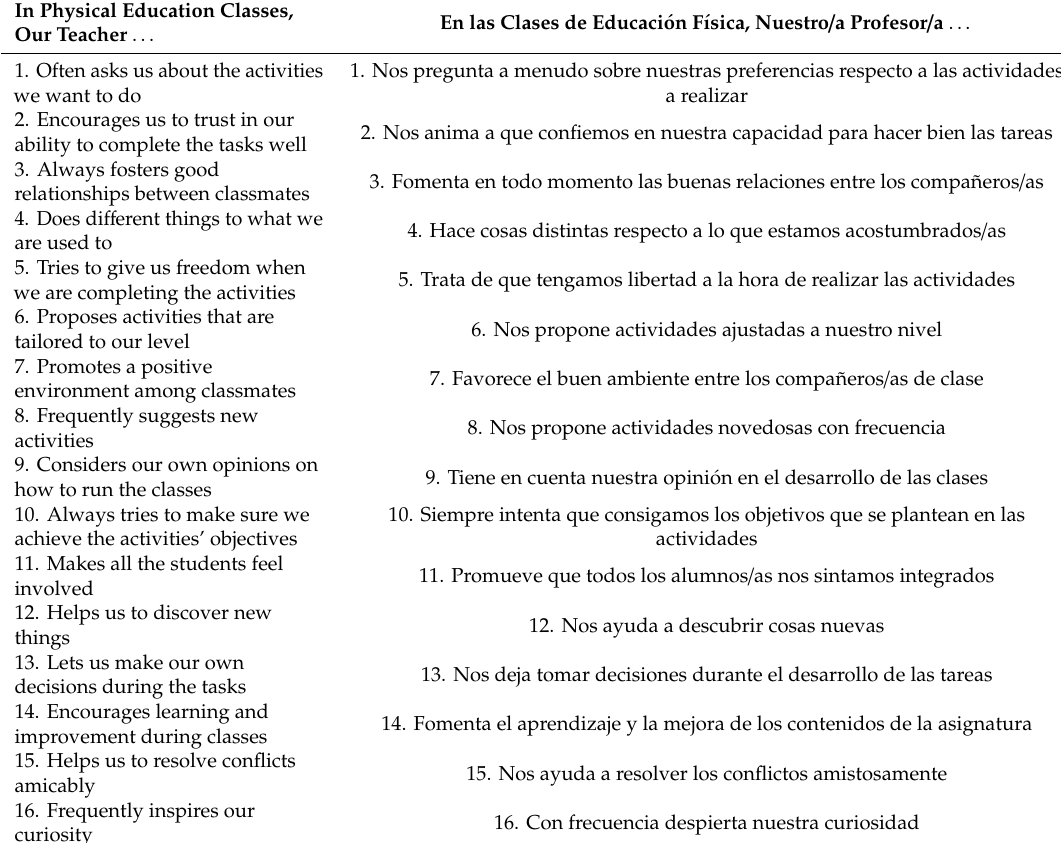
Table A1. This questionnaire was validated in